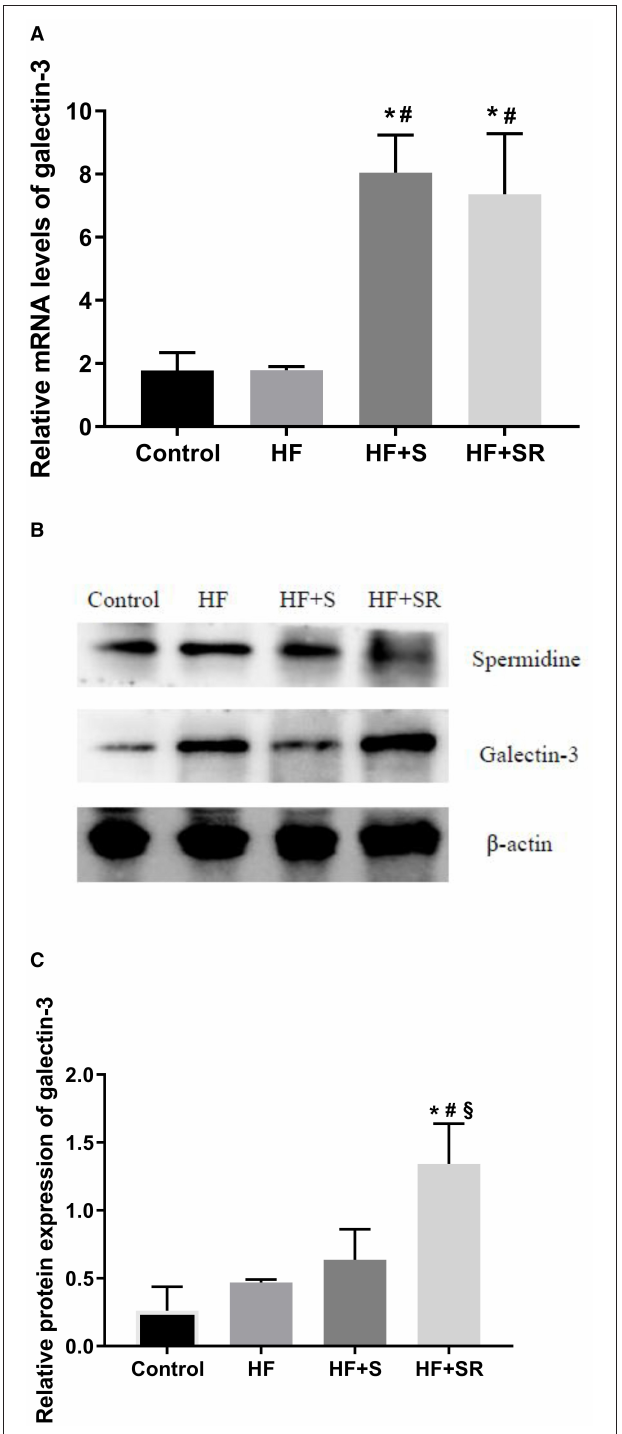
FIGURE 4 | The mRNA and protein expression of galectin-3 in the heart in different groups. Relative mRNA levels of galectin-3 in the heart (A) . Representative immunoblots for galectin-3 in the heart (B) . Quantitation of galectin-3 protein levels in the heart (C) . * P < 0.05 vs. controls ( n = 4), # P < 0.05 vs. HF group ( n = 5) and § P < 0.05 vs. HF + S group ( n =